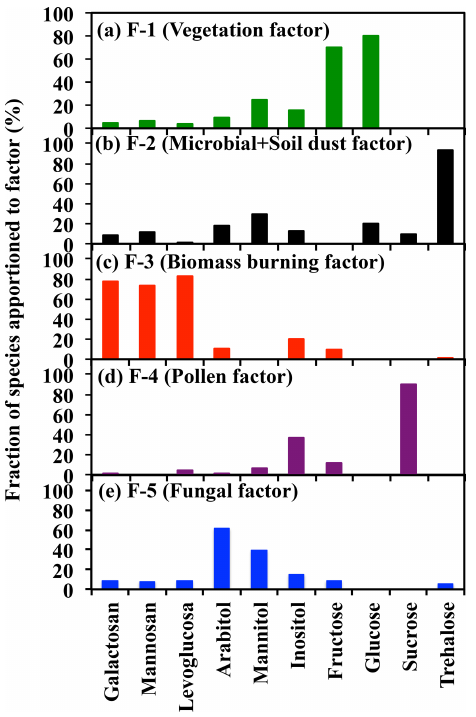
Figure 7. PMF analyses of sugar compounds in Mangshan aerosols based on the autumn 2007 data set.